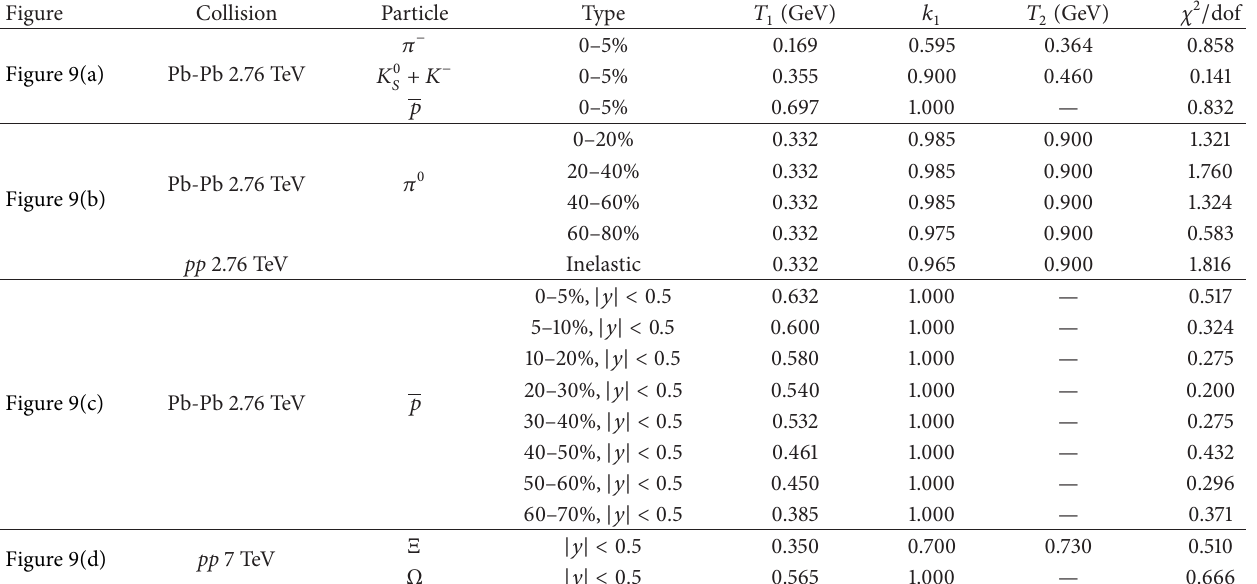
Table 9: Parameter values corresponding to the curves in Figure 9. Figure Collision